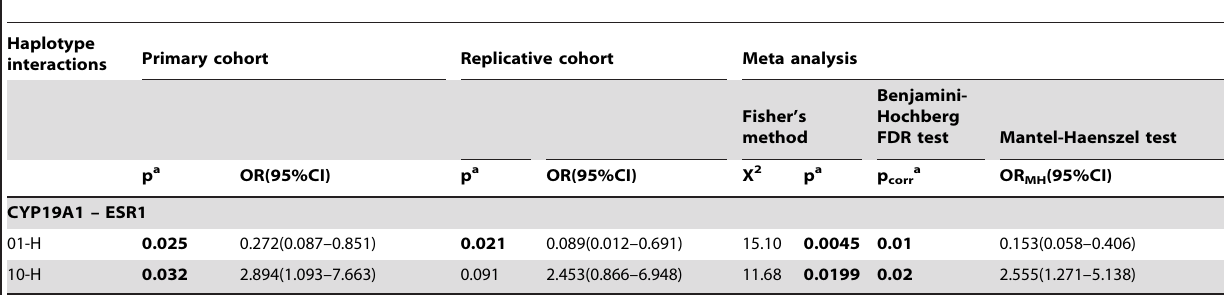
Table 6. Gene-Gene Interaction of